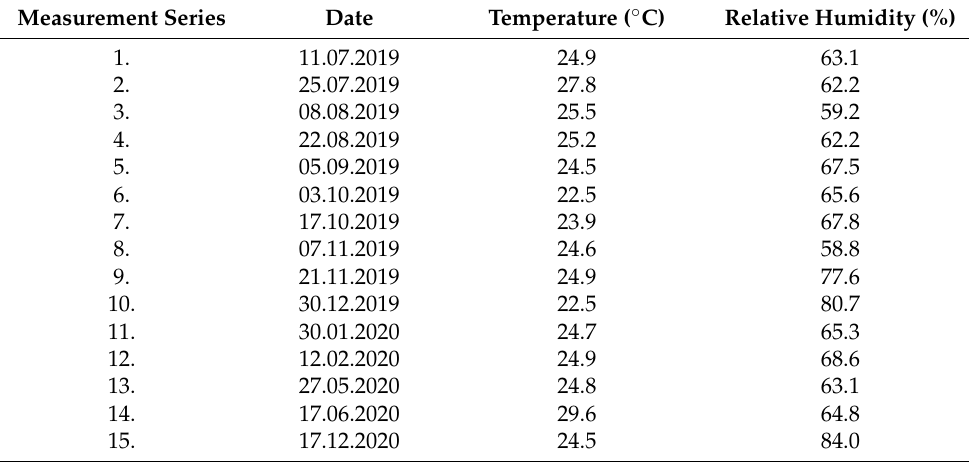
Table 4. Schedule of measurement